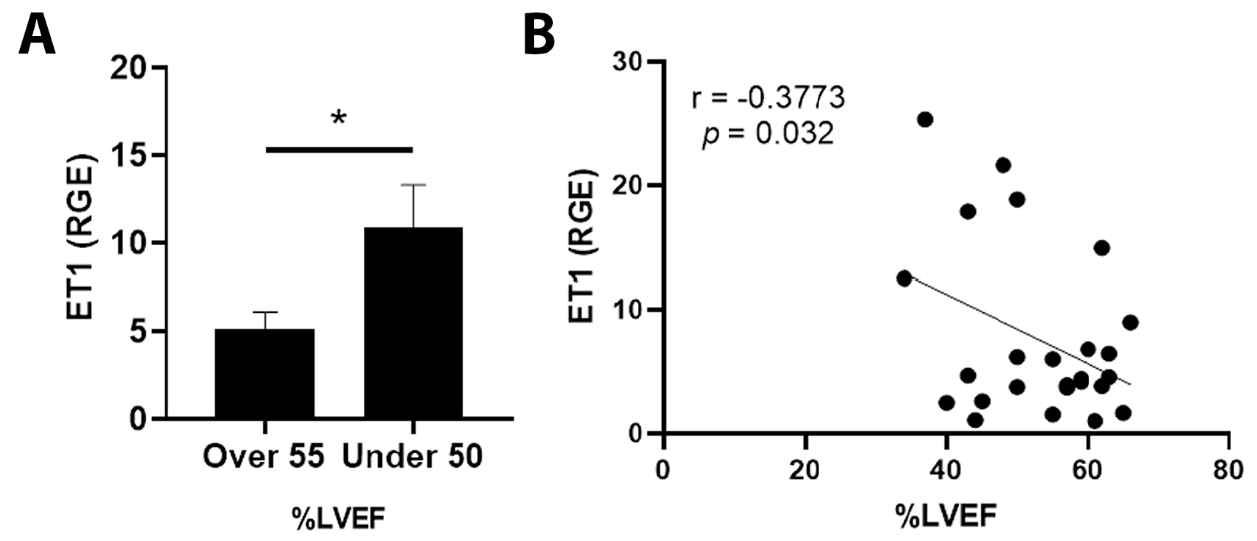
Figure 3. Relationship between LVEF of >55% or ≤50% and ET1 in tumor samples. ( A ) Relative gene expression (RGE) of ET1 by qRT-PCR (* p = 0.031) compared to the housekeeping gene PUM1. ( B ) Pearson correlation for ET1 RGE vs. percentage of LVEF showing greater ET1 expression with lower LVEF (* p = 0.032). n = 25.